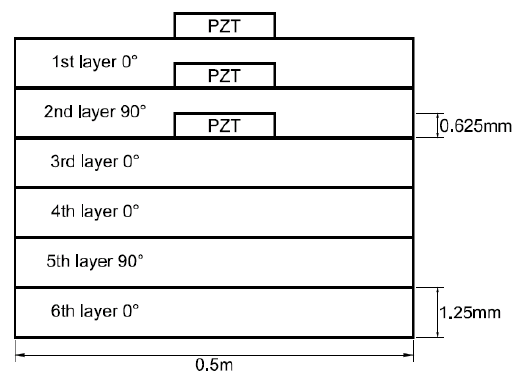
Figure 12. PZT actuators surface bonded, embedded in the first and second layers of the composite laminate.